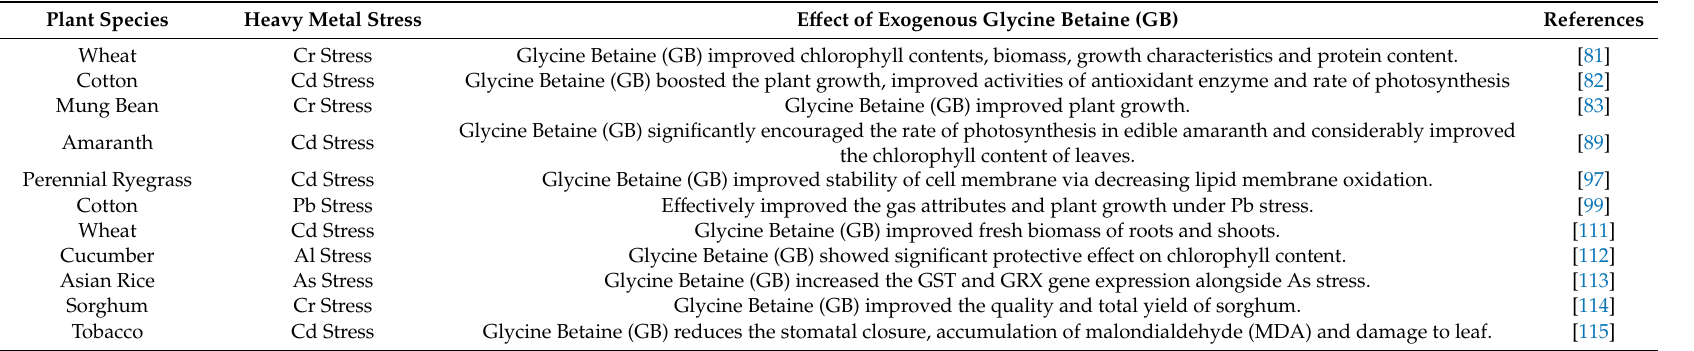
Table 1. Summary of the application of glycine betaine on various plant species under heavy metal